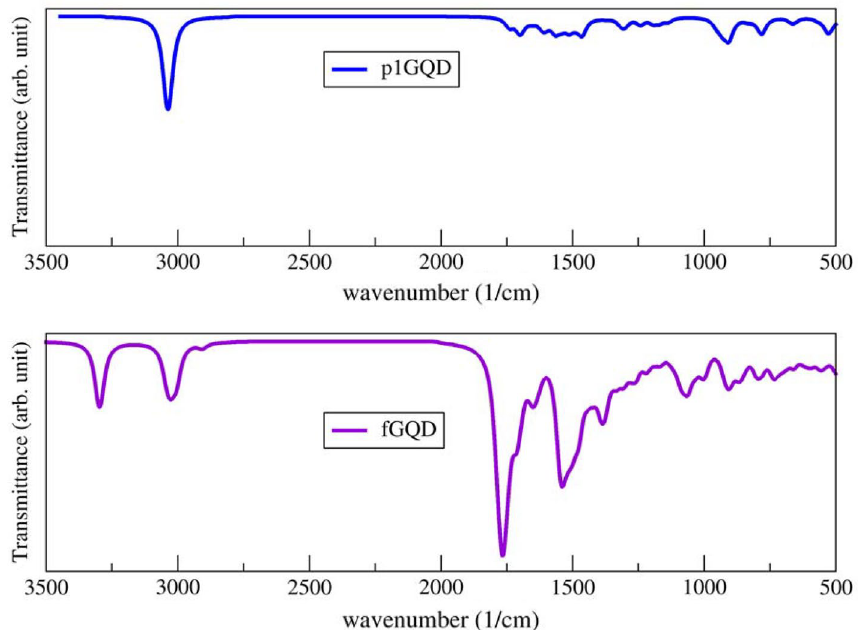
Figure 5. Simulation result of infrared spectra of p1GQD (blue) and functionalized fGQD (purple).